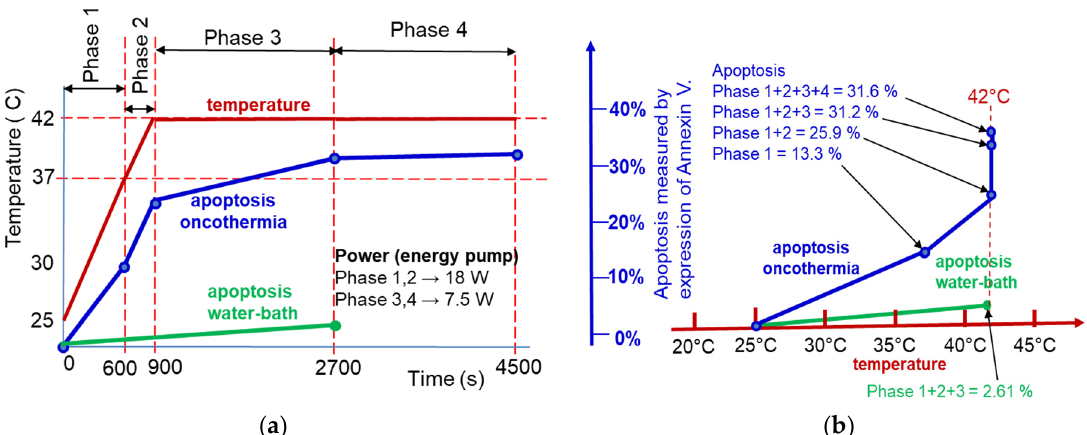
Figure 10. The effect of heating and maintaining the temperature on apoptosis. The mEHT had significantly higher apoptotic cells than the wHT at the same temperature. ( a ) The apoptosis saturated when the temperature became constant at the temperature maintenance period of treatment. ( b ) The temperature dependence of apoptosis shows a limit at the saturated temperature.